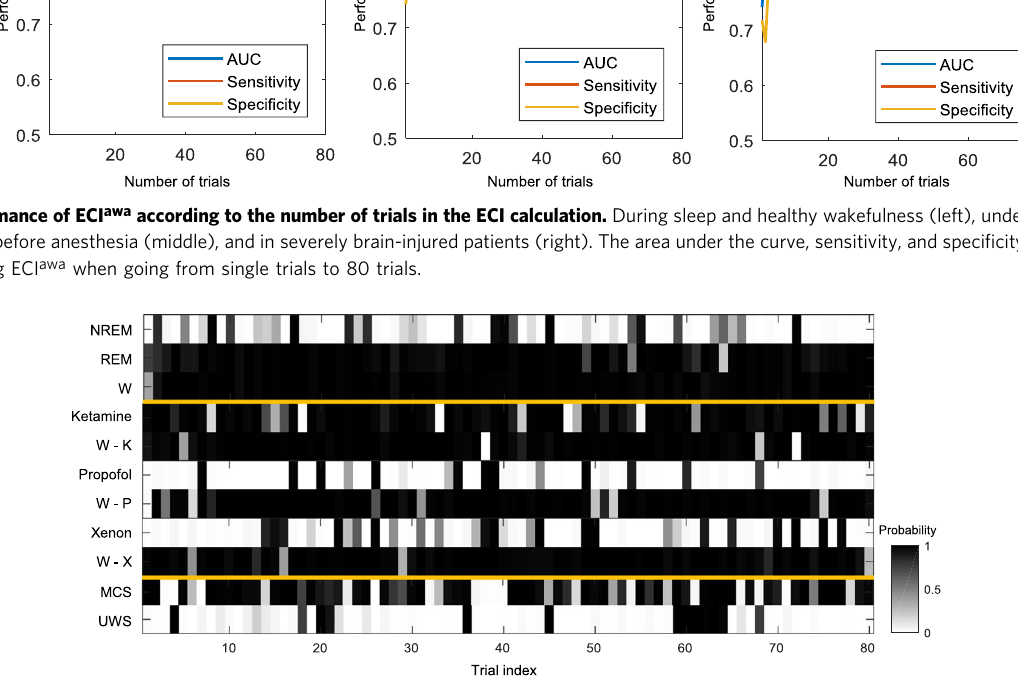
Fig. 6 Interclass probability in the representative participant for ECI awa . We depicted the probability of a representative participant (P01) in all conditions (sleep, anesthesia, DoC). P01 was the fi rst participant of each list, randomly chosen. Each colored box indicates the probability that the corresponding trial is considered as high awareness in each participant. If it was a perfect prediction in one trial, during sleep and healthy wakefulness, NREM sleep with no subjective experience (low awareness) has a probability of less than 0.5, whereas REM sleep and normal wakefulness (high awareness) have probabilities of more than 0.5. Under anesthesia and wakefulness, ketamine and wakefulness before anesthesia are high awareness, whereas propofol and xenon have low awareness. MCS and UWS patients have high and low awareness, respectively.